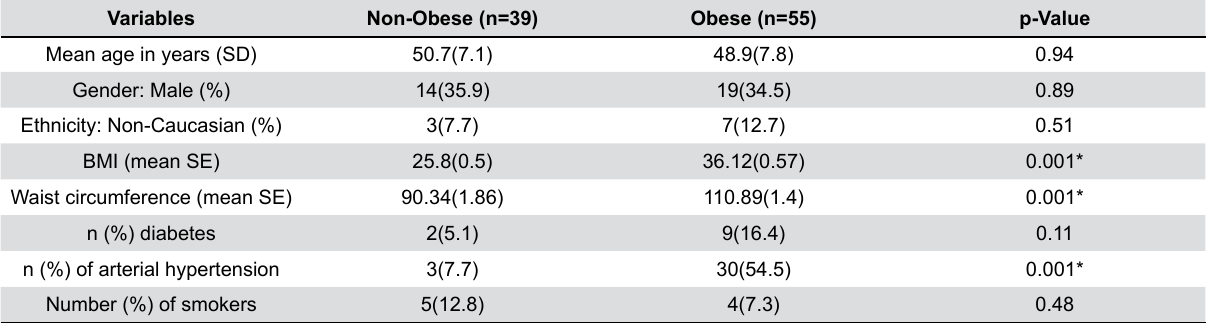
Table 1- Sociodemographic, behavioral and health condition characteristics of Obese and non-Obese Variables